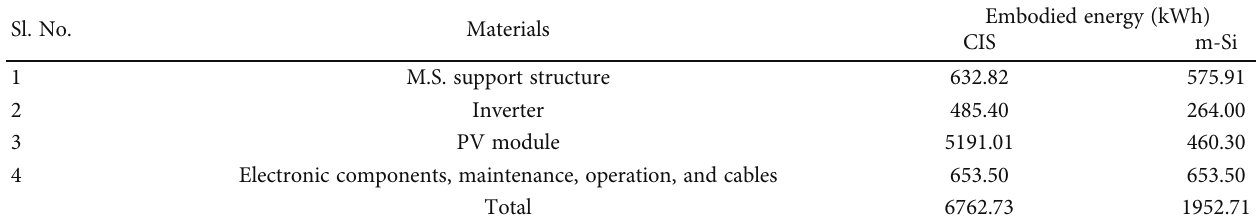
Table 11: Embodied energy ’ s breakup.